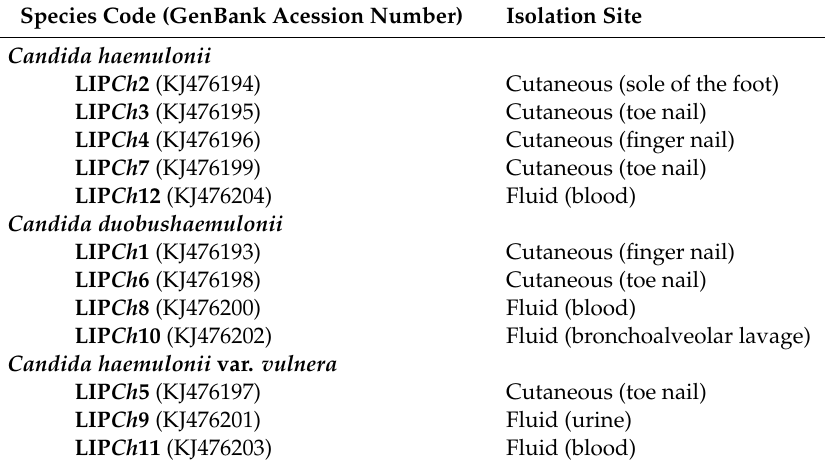
Table 1. Clinical isolates used in the present